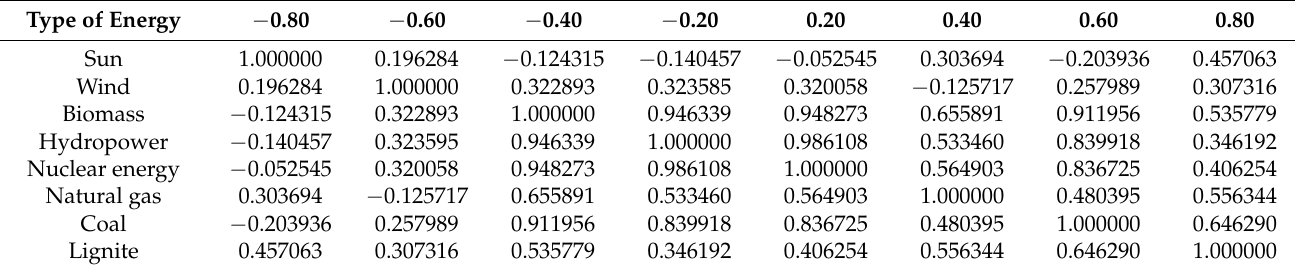
Figure 34. Statistical calculations for coal. By observing the scatter plots, it is possible to deduce what kind of relationship “we are dealing with”. The interpretation of the chart allows for the conclusion of a positive relationship (with a strong force r = (0,1)). It should be emphasized that an increase in the value of one feature causes an increase in the average values of the second feature. The numerical solution of the indicated correlation is the correlation coefficient that identifies itself with the range in the numerical interval ( − 1; 1). The correlations of the studied variables for r are presented below: − 1, − 0.8, − 0.6, − 0.4, − 0.2, 0, 0.2, 0.4, 0.6, 0.8 and 1. The values adopted for the correlation relationships are presented in Table 1 and description for correlation relationships in presented Table 2. Table 1. Correlation in terms of the possibilities of the energy market in Germany based on archival data 2011–2021. Type of